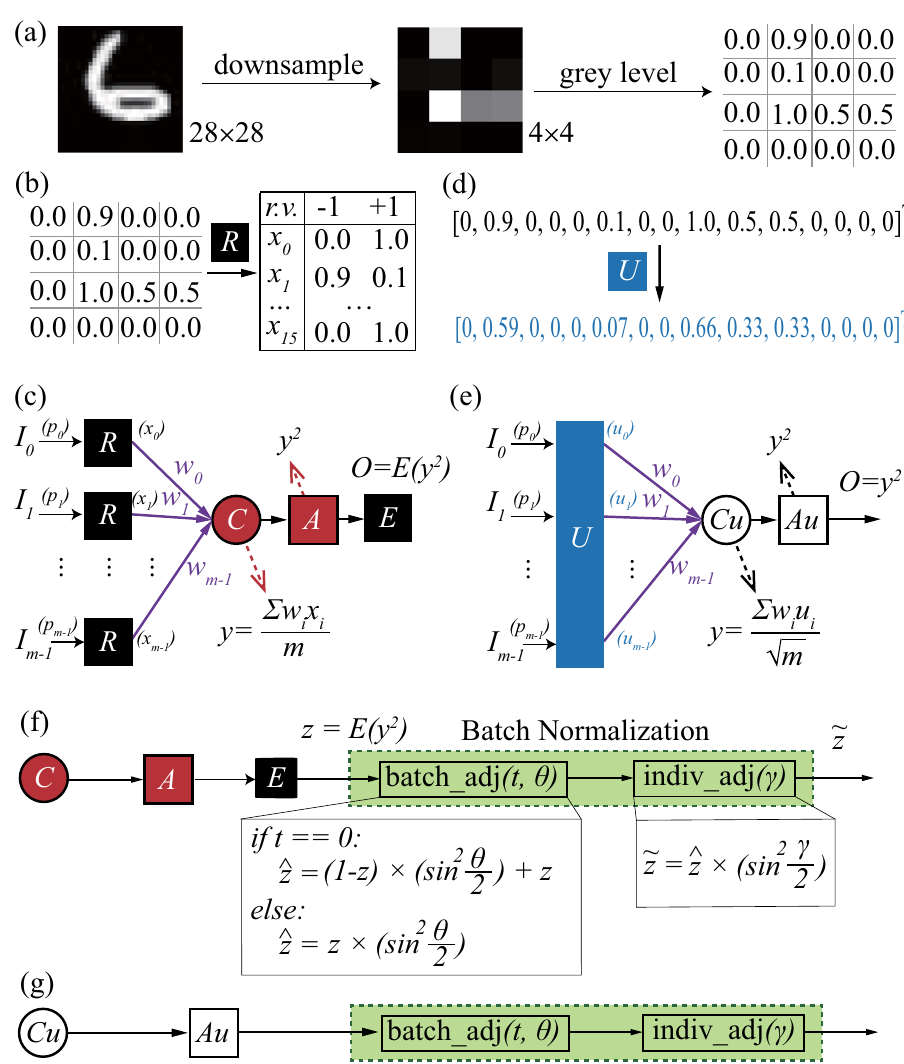
Fig. 4 Neural computation. a Prepossessing of inputs by (i) downsampling the original 28 × 28 image in MNIST to 4 × 4 image and (ii) get the 4 × 4 matrix and normalize gray level to [0, 1]. b In P-LYR, input data are converted from real number to a random variable following a two-point distribution. c Four operations in P-LYR, (i) R: converting a real number ranging from 0 to 1 to a random variable, (ii) C: average sum of weighted inputs, (iii) A: nonlinear activation function, (iv) E: converting random variable to a real number. d In U-LYR, m -input data are converted to a vector in the fi rst column of a m × m unitary matrix. e Three operations in U-LYR, (i) U: unitary matrix converter, (ii) C u : average sum of weighted inputs; (iii) A u : nonlinear activation function. f Normalization for the connection of P-LYR. g Normalization for the connection of U-LYR.